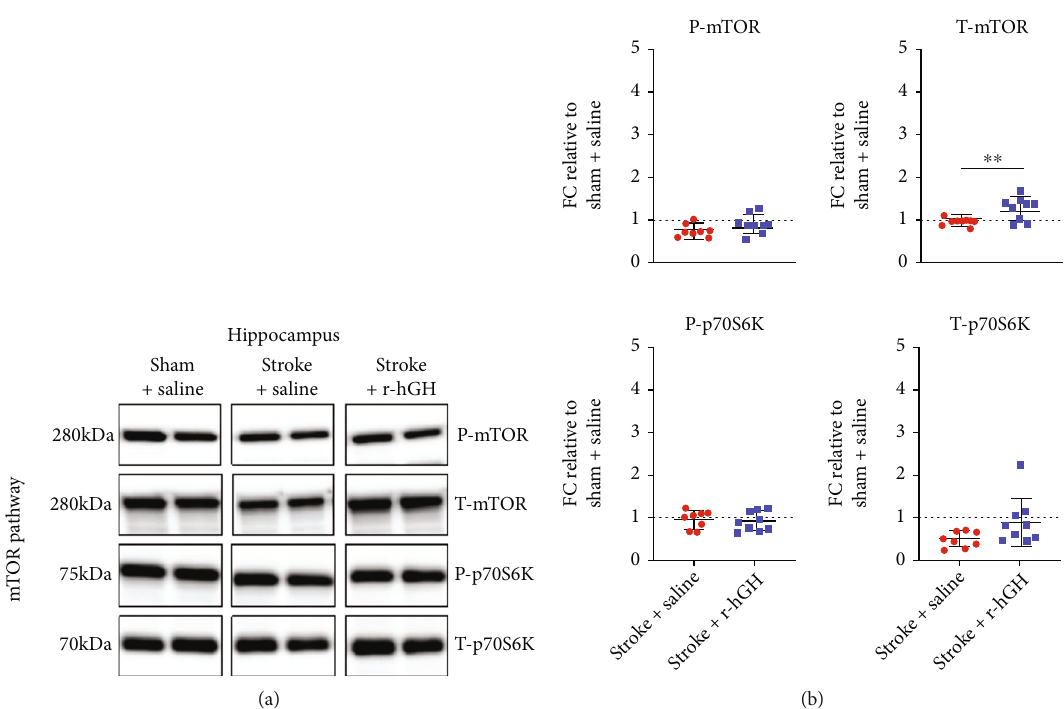
Figure 4: The e ff ect of recombinant human growth factor (r-hGH) treatment poststroke on mammalian target of rapamycin (mTOR) in the thalamus. (a) Representative blots of phosphorylated-mTOR (P-mTOR, active form), total-mTOR (T-mTOR), phosphorylated-p70S6- kinase (P-p70S6K), and total-p70S6K (T-p70S6K). (b) Data are presented as in Figure 2. We found a signi fi cant increase in T-mTOR protein expression within the thalamus in stroked mice treated with r-hGH (blue squares) compared with saline (red circles). ∗∗ p < 0 : 01 , 2-tailed t